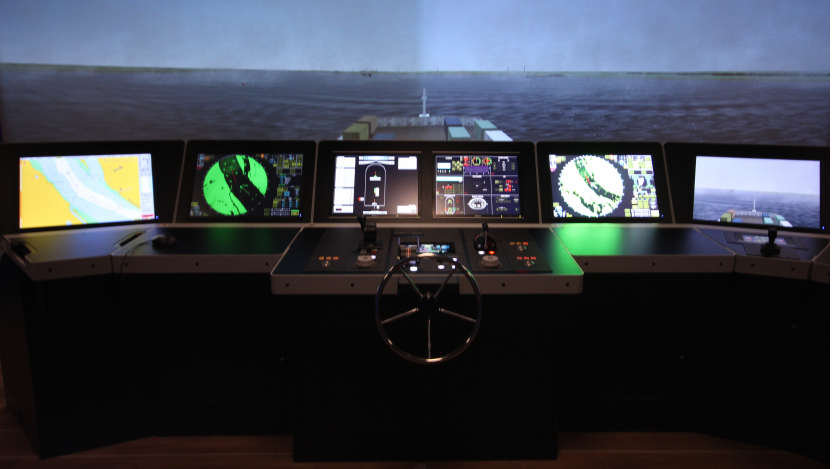
Figure 7. Experimental setup on vessel simulator, at the Norsk Maritimt